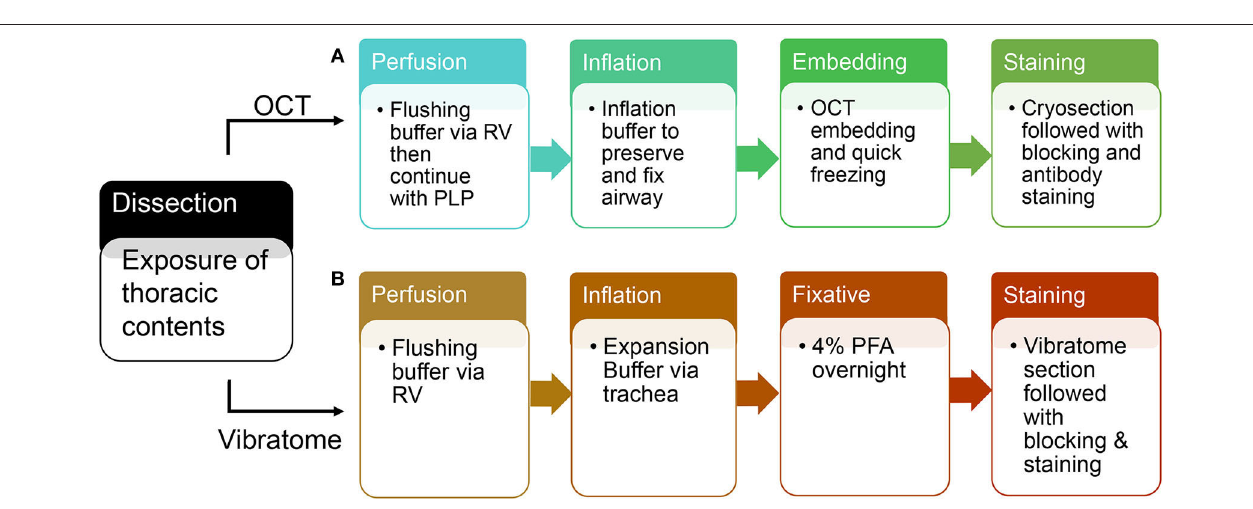
FIGURE 2 | A schematic flow of OCT tissue preparation and vibratome tissue preparation. (A) An overview of steps in tissue preparation using OCT. (B) An overview of steps in tissue preparation using low melting agarose.